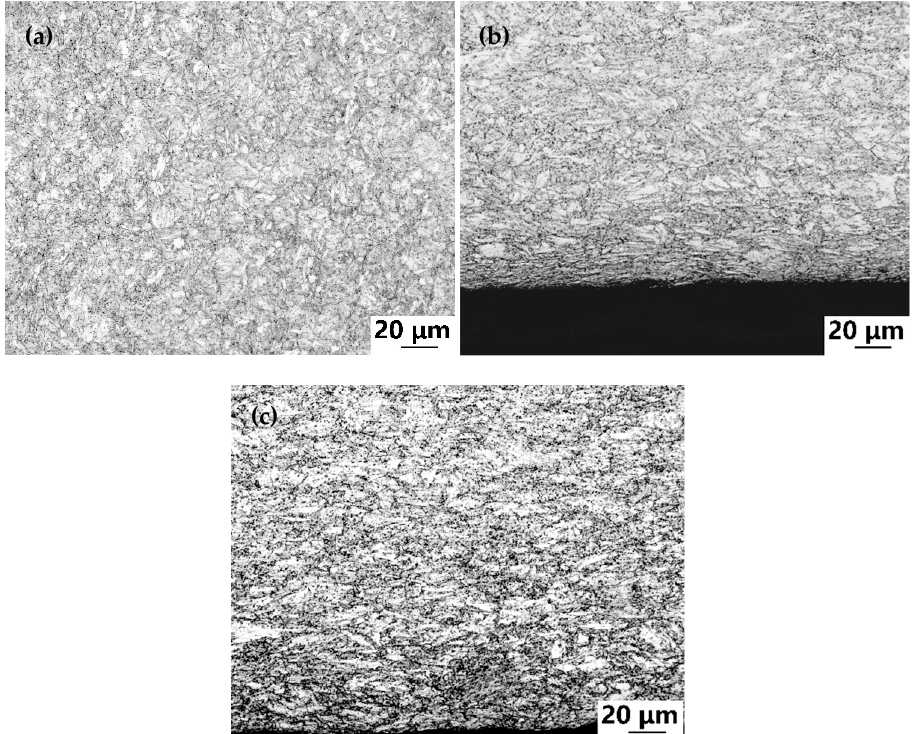
Figure 7. Microstructure of cross section near inner wall ( a ): quenching and tempering, ( b ): after rolling and ( c ): vacuum tempering.